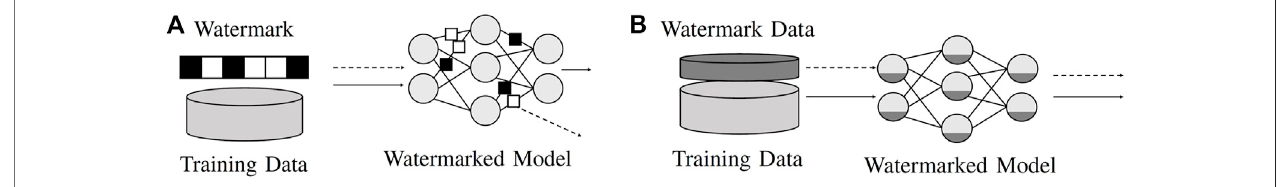
FIGURE 4 | Two broad approaches for watermarking ML models. (A) De fi ne a watermarking bit string and embed it into the model parameters. For veri fi cation, retrieve bit values from parameters and compare the result with that of the original string. (B) Train the model on the original data and a separate watermarking trigger dataset. For veri fi cation, query the trigger dataset and verify the labels with regard to the trigger dataset labels.